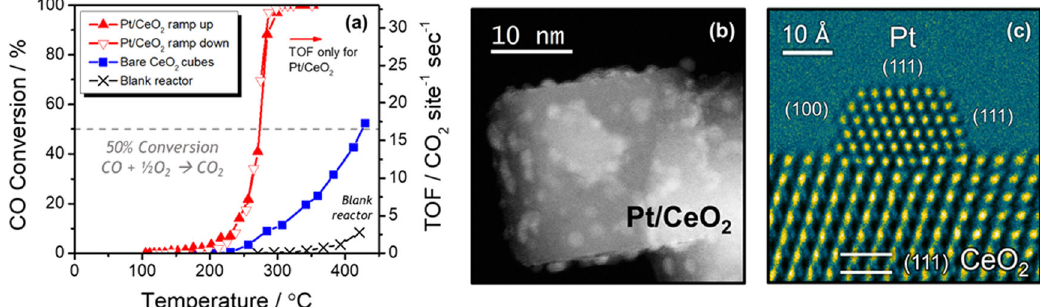
Fig. 1 Activity and structural characterization of Pt/CeO 2 catalyst. a Catalytic activity for CO oxidation was evaluated in a packed-bed plug- fl ow reactor. The activity of the bare CeO 2 support is demonstrably less and the effect of the blank reactor is negligible. b Z-contrast STEM image of a typical Pt-loaded CeO 2 nanoparticle showing the dispersion of roughly 1.6 nm Pt nanoparticles loaded on the CeO 2 nanoparticle support. c HRTEM image of a typical